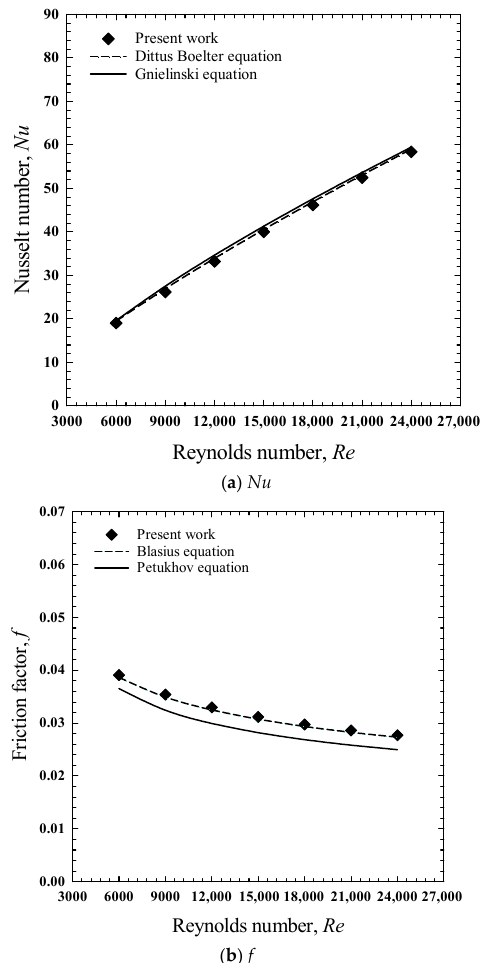
Figure 3. Validation test of a smooth channel: ( a ) Nusselt number as a function of Reynolds number; and ( b ) friction factor as a function of Reynolds number.